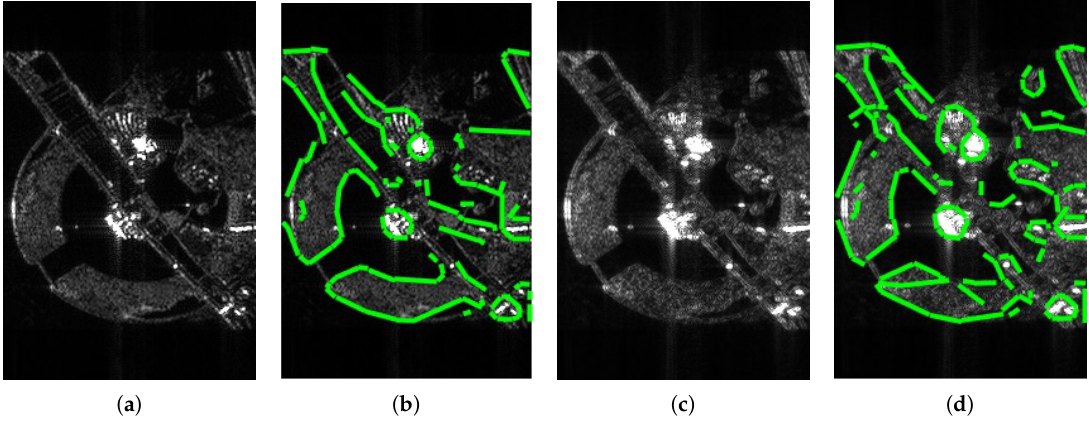
Figure 9. The imaging and edge detection result of complex area2. ( a ) Original image; ( b ) edge detection result of the original image; ( c ) edge-enhanced SAR image; ( d ) edge detection result of the edge-enhanced SAR